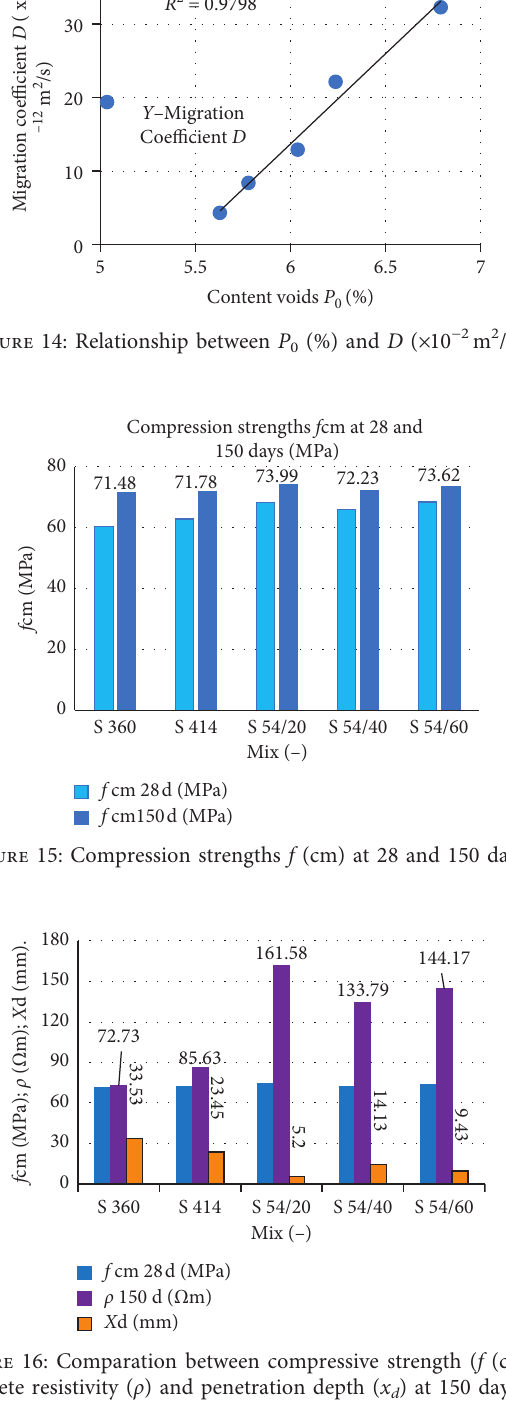
Figure 16: Comparation between compressive strength ( f (cm)), concrete resistivity ( ρ ) and penetration depth ( x d ) at 150